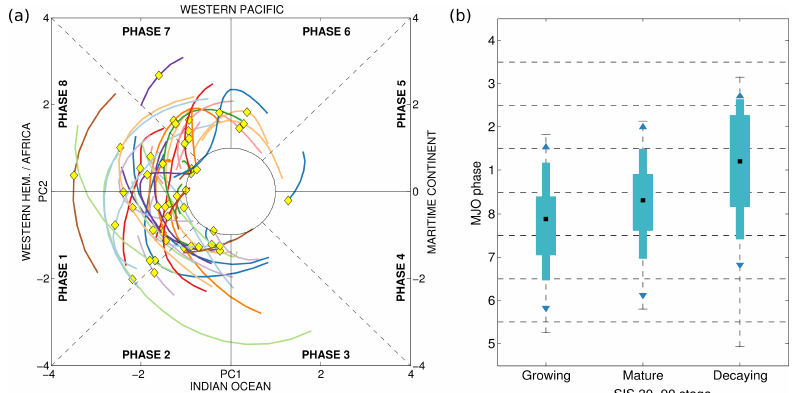
Figure 3. ( a ) MJO phase diagram with the daily MJO index values during negative SIS events within an MJO event. The yellow diamond indicates the day in which the SIS index is minimum and ( b ) Boxplot of the average phase angle for the growing, mature and decaying stages of positive SIS events (see text for definitions). Rest as in Figure 2.